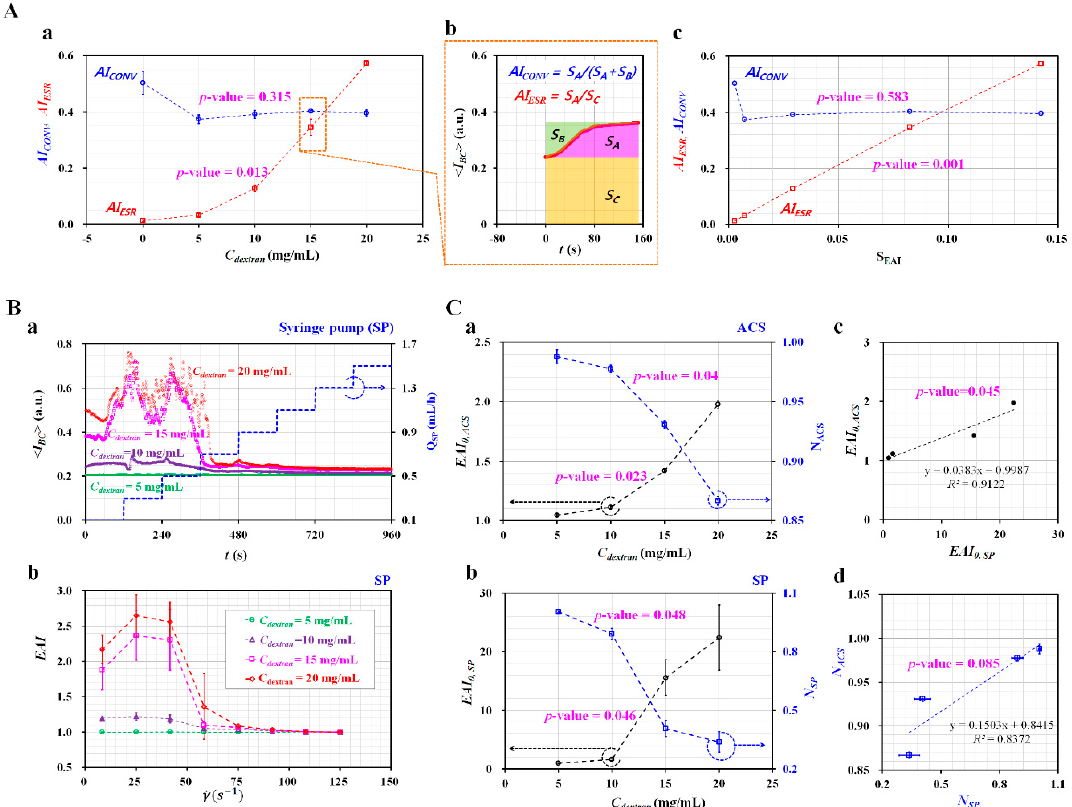
Figure 6. Quantitative comparison of RBCs aggregation between the proposed method and the previous method. Blood sample ( Hct = 50%) was prepared by adding normal RBCs into a specific dextran solution ( C dextran = 0, 5, 10, 15, and 20 mg / mL). ( A ) Comparison between S EAI (i.e., without information on shear rate) and previous RBCs aggregation indices ( AI conv , AI ESR ). ( a ) Variations of AI conv and AI ESR with respect to C dextran . ( b ) Definition of the previous RBCs aggregation indices: AI conv = S A / ( S A + S B ), and AI ESR = S A / S C . ( c ) The relationship between proposed RBCs aggregation index ( S EAI ) and previous RBCs aggregation indices ( AI conv , AI ESR ). ( B ) Quantitative evaluation of EAI (i.e., with information on shear rate) with respect to ACS and syringe pump. ( a ) Temporal variations of EAI obtained using the syringe pump. ( b ) Temporal variations of EAI obtained by ACS . ( C ) Comparison of two parameters ( EAI 0 , and N ) obtained by ACS and the syringe pump (SP). ( a ) Variations of EAI 0 ,ACS and N ACS obtained by ACS with respect to C dextran . ( b ) Variations of EAI 0 ,SP and N SP obtained using the syringe pump with respect to C dextran . ( c ) Relationship between EAI 0 ,ACS and EAI 0 ,SP . ( d ) Relationship between N ACS and N ACS .